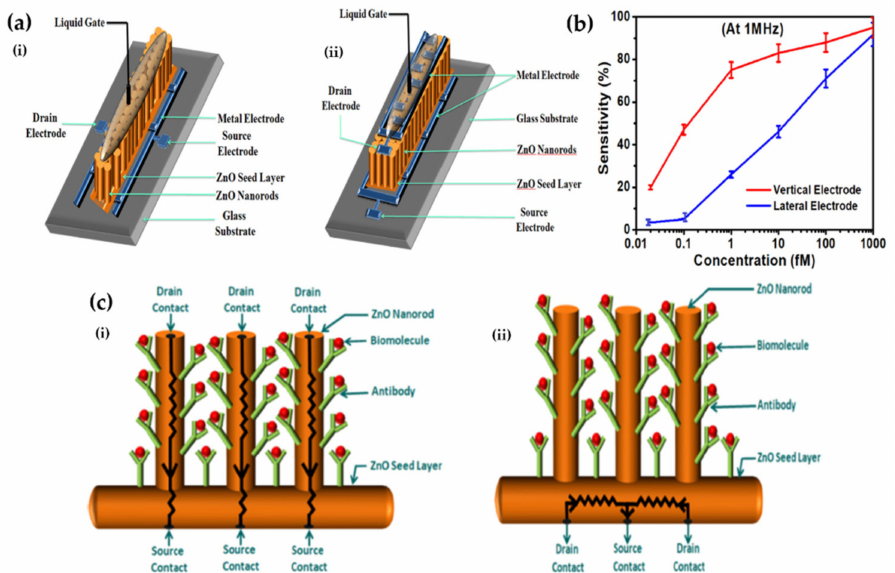
Figure 5. ( a ) Schematic illustration of the zinc-oxide-nanorod-field-effect-transistor-based (ZnO- NR-FET) immunosensors with lateral ( i ) and vertical ( ii ) electrode configuration, respectively. ( b ) Variation of sensitivity with different antigen concentrations for 1 MHz frequency for vertical and horizontal electrode configuration. ( c ) Resistance model for vertical ( i ) and lateral ( ii ) electrode configuration. Adapted from [130] with permission from